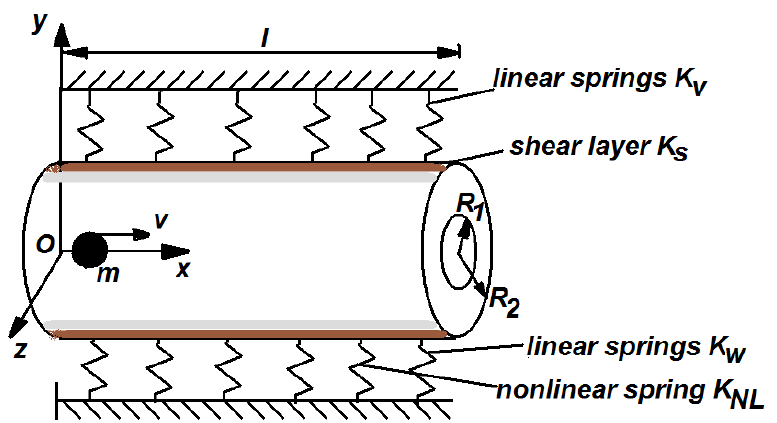
Figure 1. Geometry of DWCNT on Winkler–Pasternak foundation under the moving nanoparticle. The Winkler–Pasternak foundation is characterized by shear layer constant K s , the linear spring K w and nonlinear spring K NL . Through inner tube moves the nanoparticle of mass m and with constant speed v. While the nanoparticle arrives at the right end, another nanoparticle moves immediately. Simply supported boundary conditions are assumed. The extended Hamilton principle for a system with changing mass and based on Euler–Bernoulli beam theory can be written as